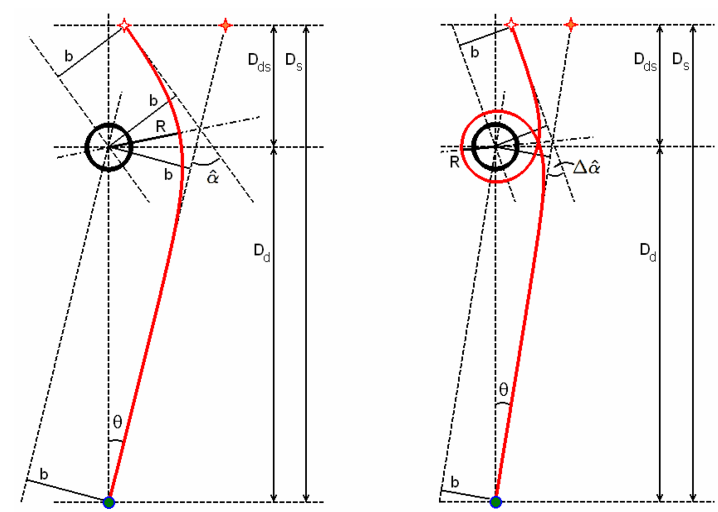
Figure 4. Scheme of formation of primary ( left ) and high-order ( right ) images of source in case of gravitational lensing by black hole in vacuum. Trajectories of light rays are calculated in the Schwarzschild metric. Light ray from the source deflected by the point-mass gravitational lens goes to the observer. The observer sees the image of the source at angular position θ , which is different from the real source position. R is the closest point of trajectory to gravitating center, it is usually referred as the distance of the closest approach, b is the impact parameter of the photon, D d is the distance between observer and lens, D s is the distance between observer and source, D ds is the distance between lens and source. In case of high-order image (right), the light ray from the source is deflected by angle ˆ α = 2 π + ∆ ˆ α , and the impact parameter b is close to its critical value b cr .